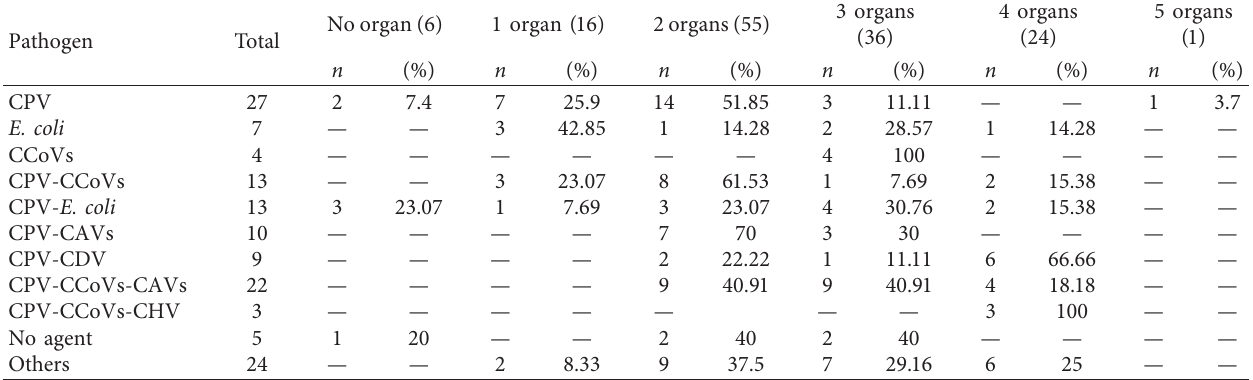
Table 5: Correlation between dissemination of the lesions and the prevalent pathogens.